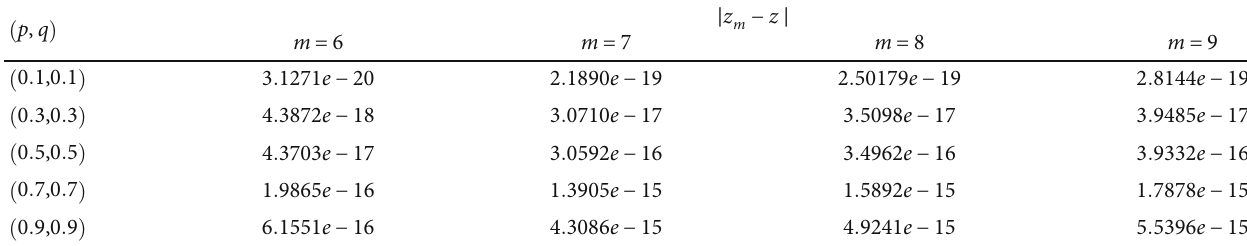
Table 10: The absolute error for di ff erent values m for Example 10 at various points ð p , q Þ .